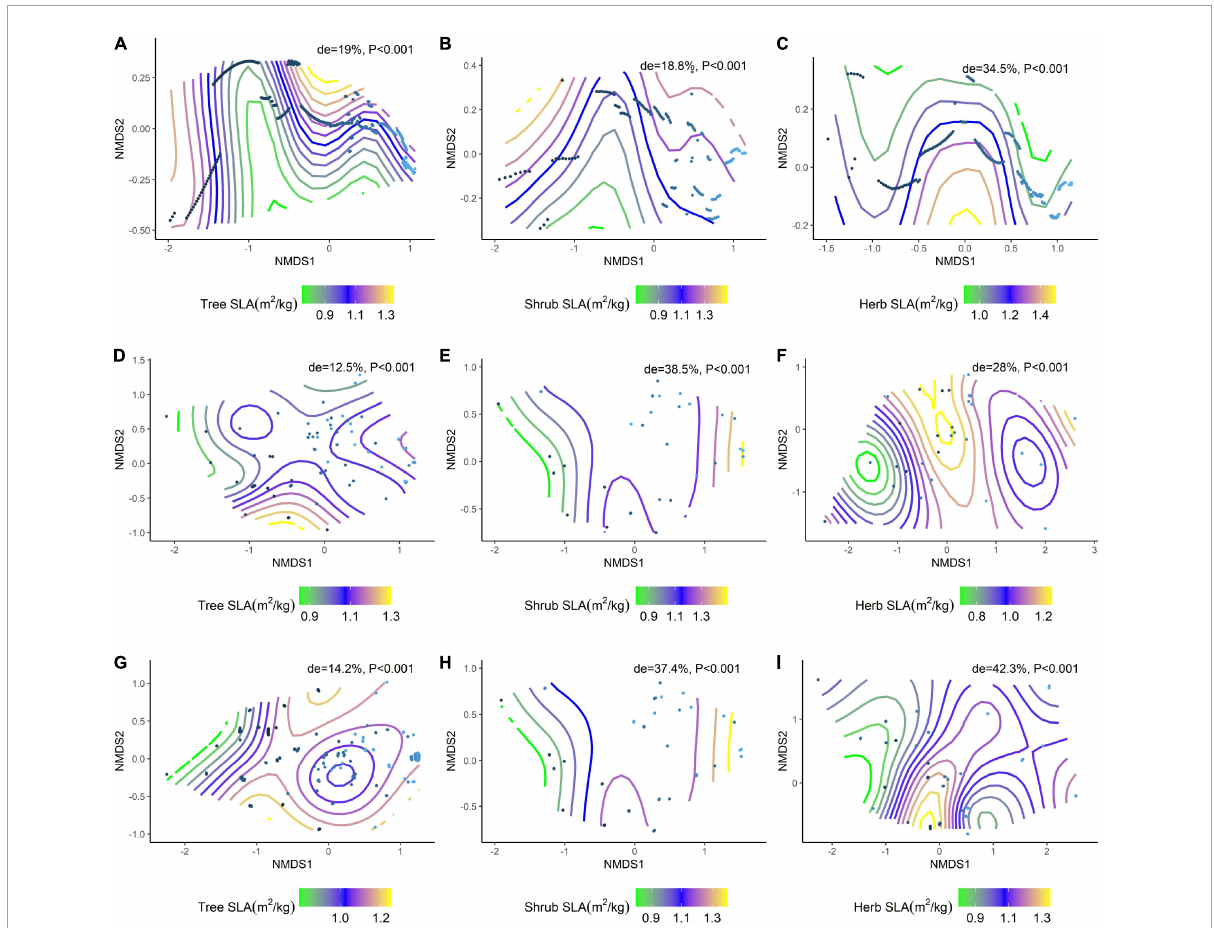
FIGURE6 NMDS ranking of climatic and soil factors with different life forms of SLA. (A) NMDS ranking of soil factors with tree lSLA; (B) NMDS ranking of soil factors with shrub SLA; (C) NMDS ranking of soil factors with herb SLA; (D) NMDS ranking of climatic factors with tree SLA; (E) NMDS ranking of climatic factors with shrub SLA; (F) NMDS ranking of climate factors and herb SLA; (G) NMDS ranking of the sum of soil factors and climate factors and tree SLA; (H) NMDS ranking of the sum of soil factors and climate factors and shrub SLA; (I) NMDS ranking of the sum of soil factors and climate factors and herb SLA. Trait stacking indicates that abiotic factors, indicated by points on the NMD, are associated with higher or lower trait values, consistent with a colored trait gradient. Note that if the relationship between SLA and abiotic factors is linear, the gradient splines are parallel. Non-linear relationships between SLA and abiotic factors are represented by curve